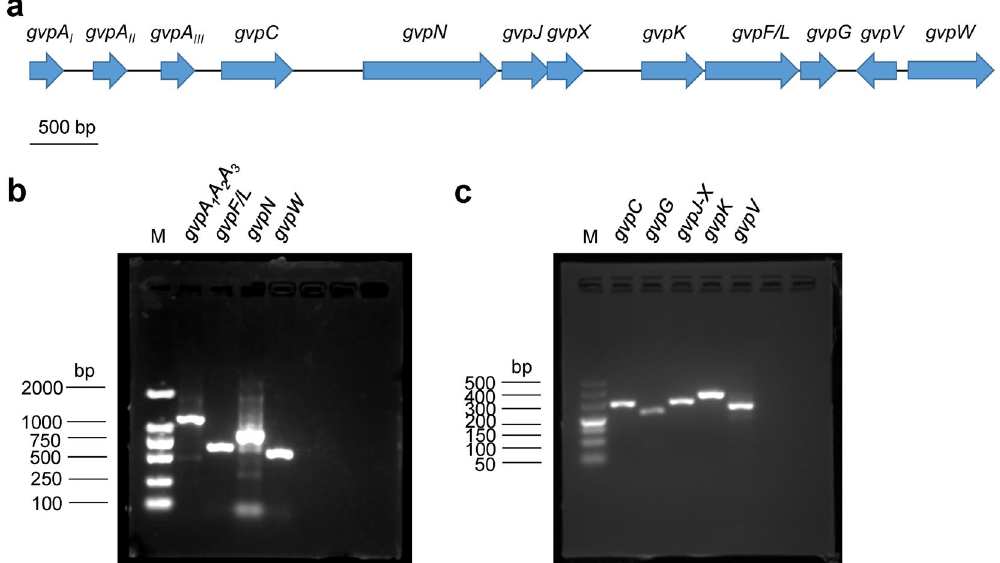
Figure 8. Organization and transcriptional analysis of genes involved in gas vesicle synthesis of M. aeruginosa CHAOHU 1326. The organization of the gvp gene cluster in M. aeruginosa CHAOHU 1326 is shown in panel a. The RT-PCR products of gvpA , gvpF/L , gvpN , and gvpW are shown in panel b, and the amplicons of gvpC , gvpG , gvpJ-X , gvpK , and gvpV are shown in panel c. (M) is a corresponding DNA molecular mass